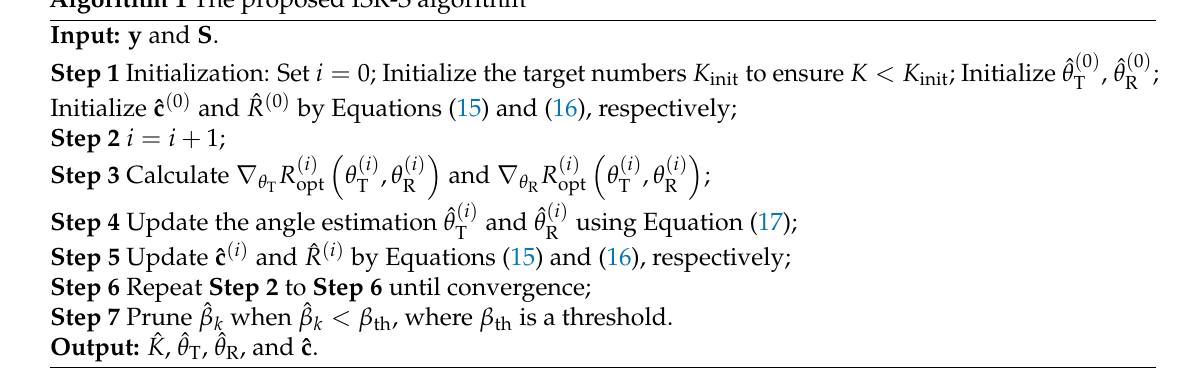
Algorithm 1 The proposed ISR-S